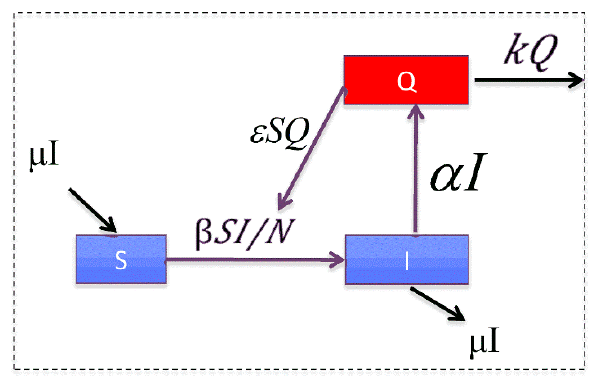
Figure 1. Graphical representation of the model.